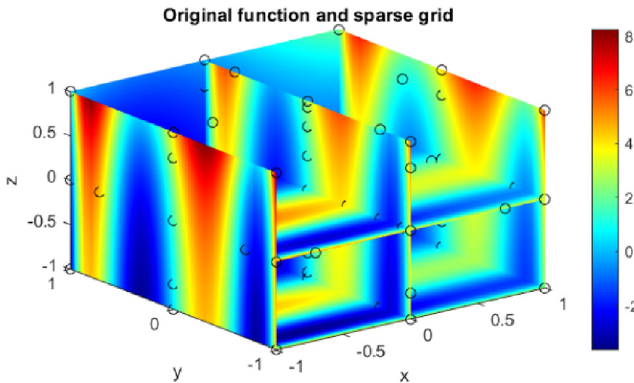
Fig. 5 Plot of the original function and the training set (circles) used to construct the PGD models